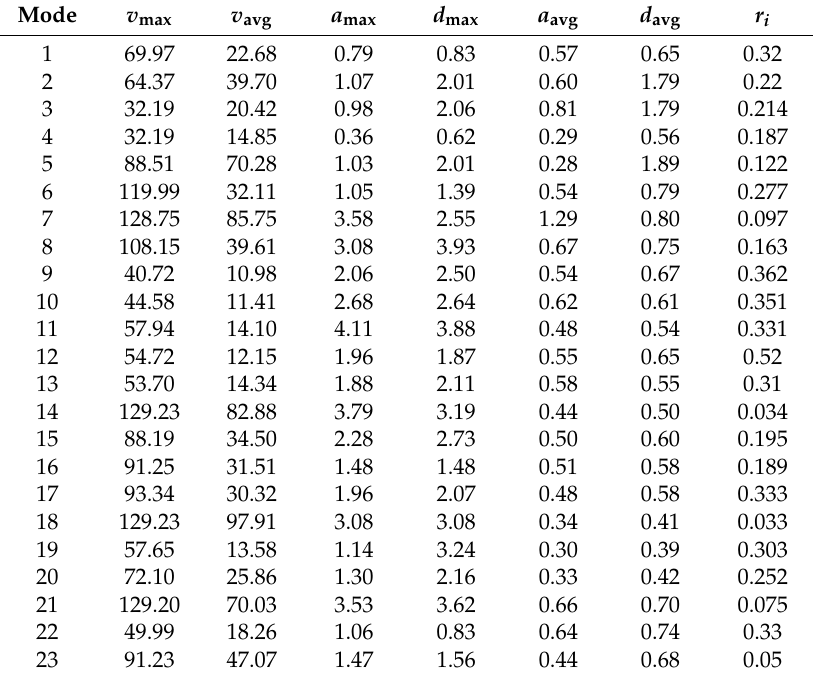
Table 8. Related characteristic parameters of twenty-three typical